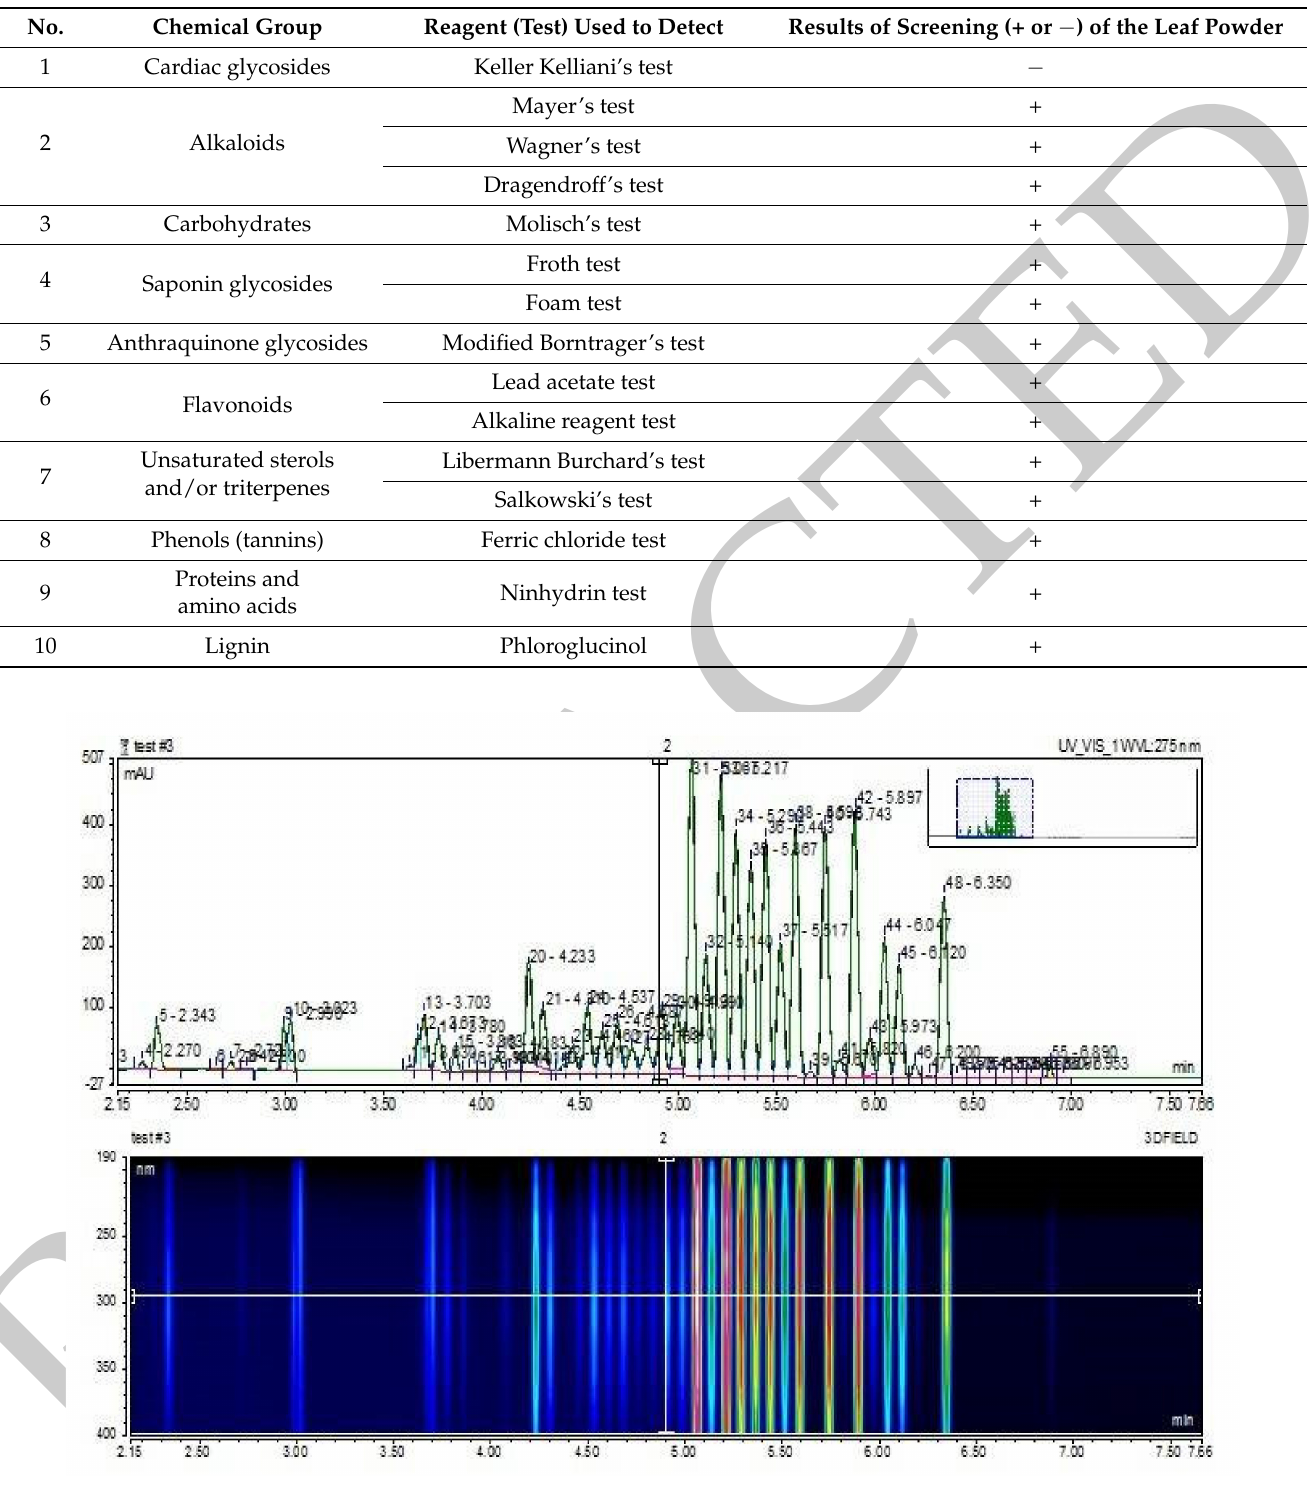
Table 1. Chemical components of the Combretum molle plant’s dried leaves.